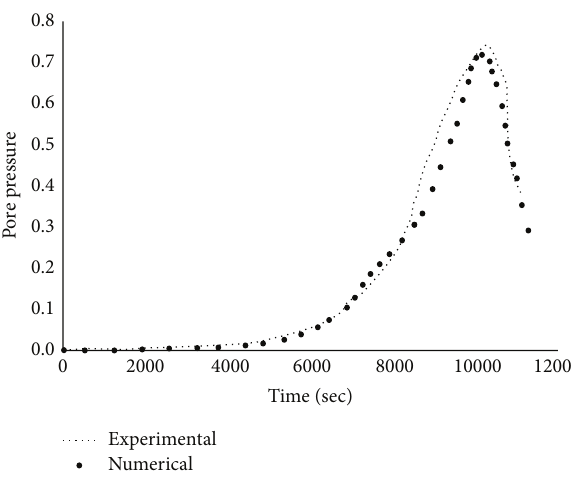
Figure 3: Pore pressure temporal evolution; numerical and experi- mental comparison at 25 mm of depth from the heat